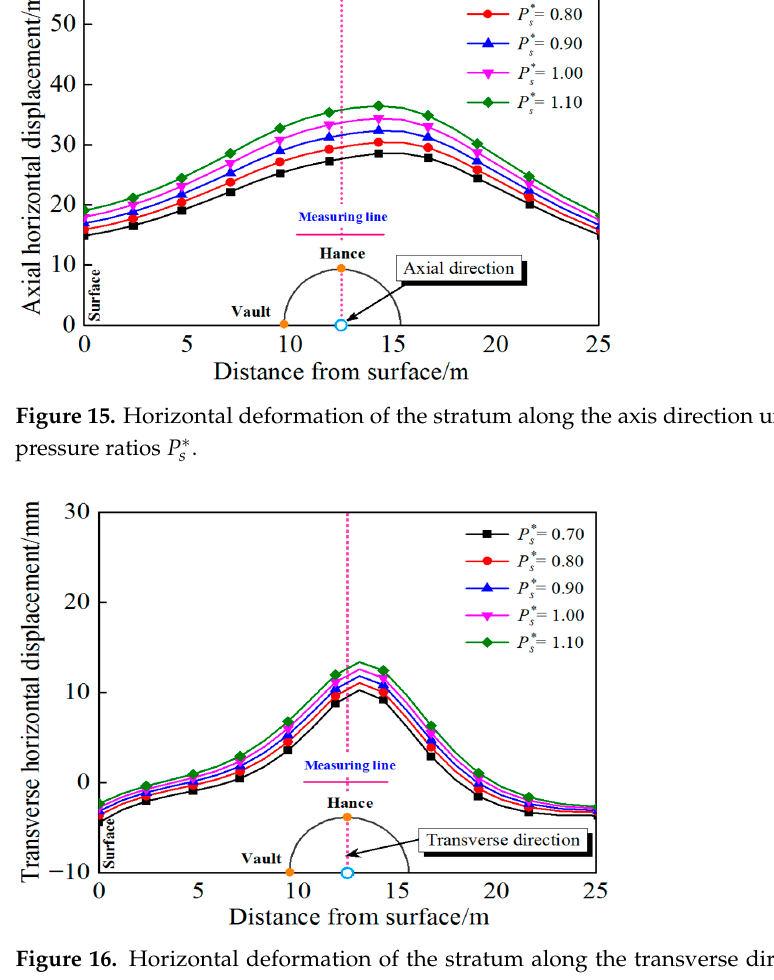
Figure 16. Horizontal deformation of the stratum along the transverse direction under different support pressure ratios P ∗ s .